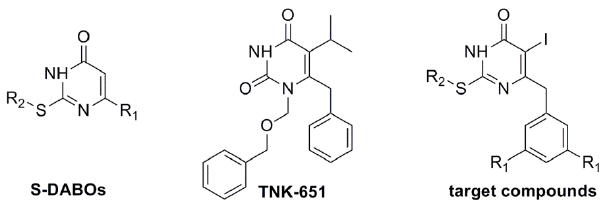
Figure 2. Structures of S-DABOs, TNK-651 and target compounds.